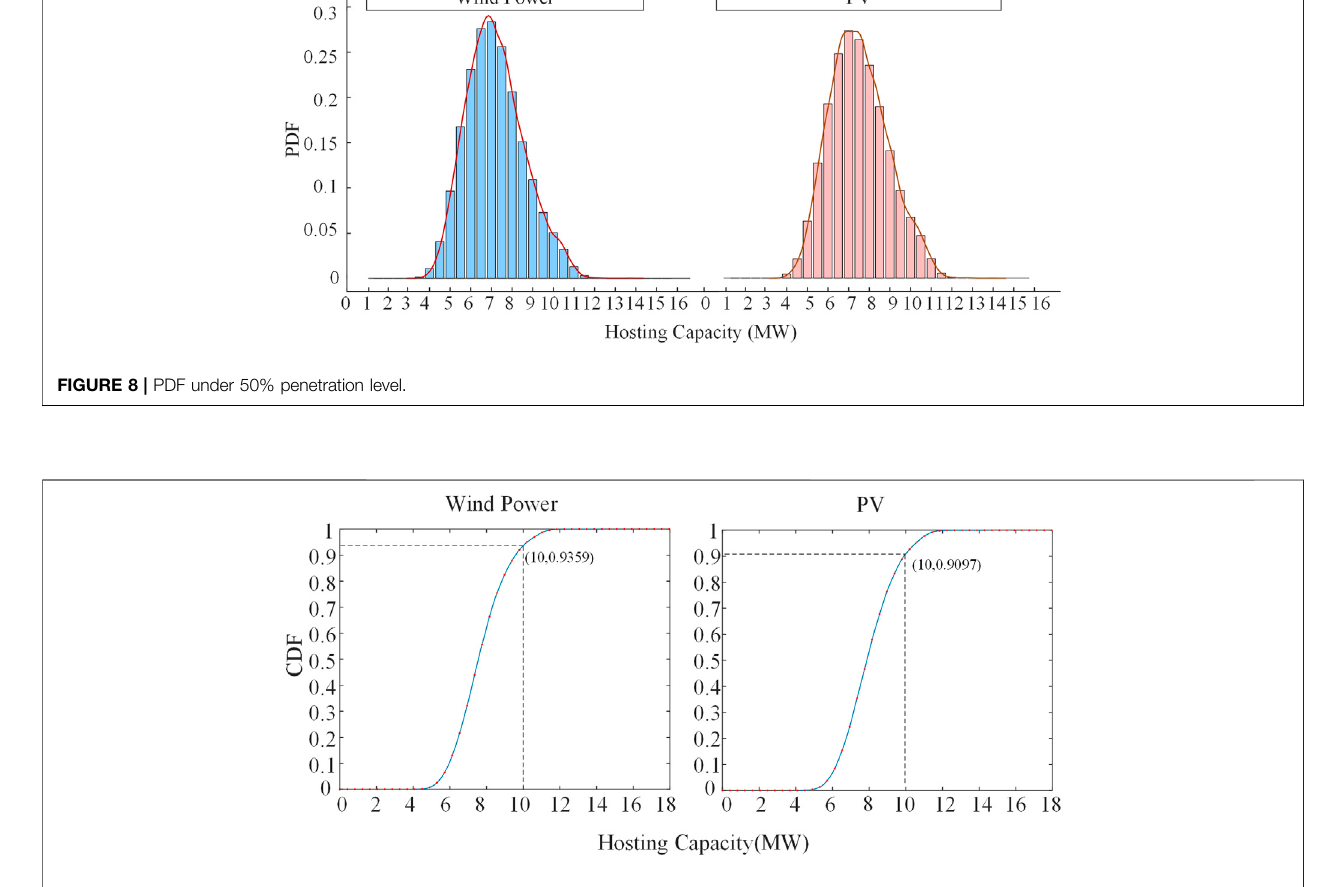
FIGURE 9 | CDF under 50% penetration level.